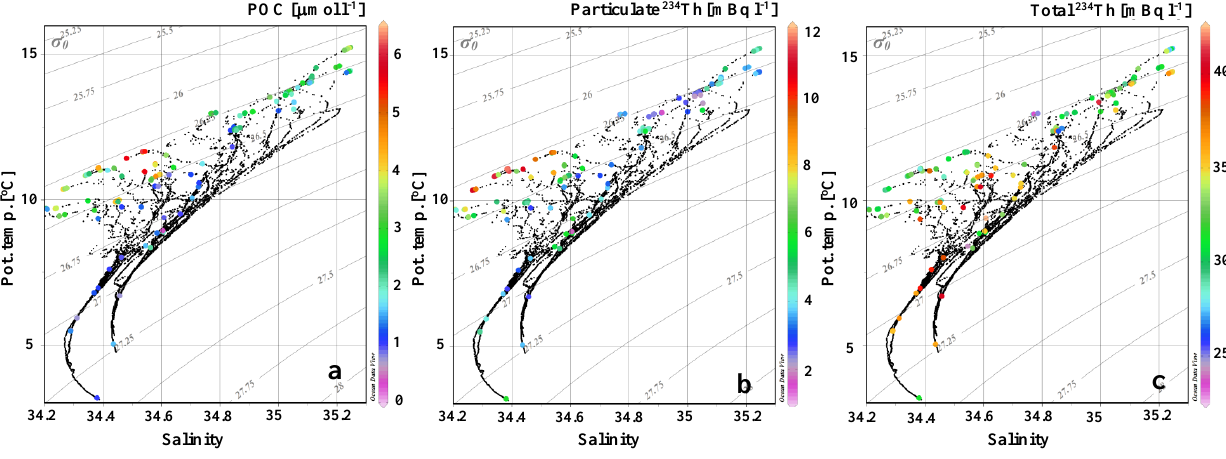
Fig. 6. Regional distributions of: (a) particulate organic carbon, (b) particulate 234 Th, and (c) total 234 Th plotted on a T-S